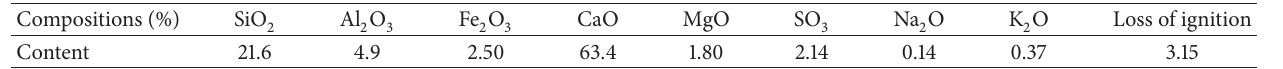
Table 2: The main chemical composition of cement